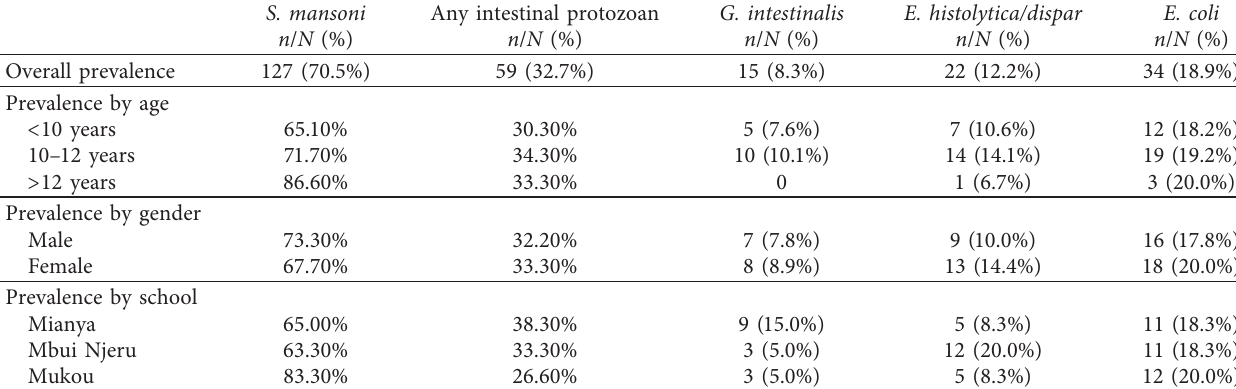
Table 1: Prevalence of S. mansoni and intestinal protozoa infections by categories, age, sex, and